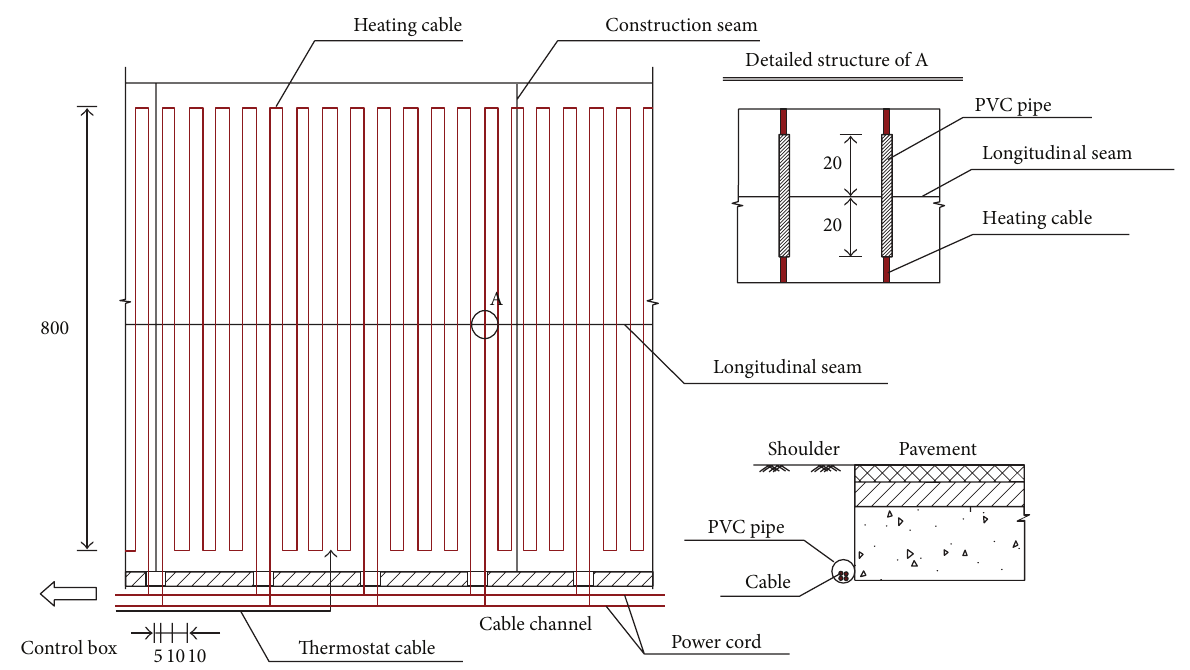
Figure 4: Working principle of the electric heat tracing system.